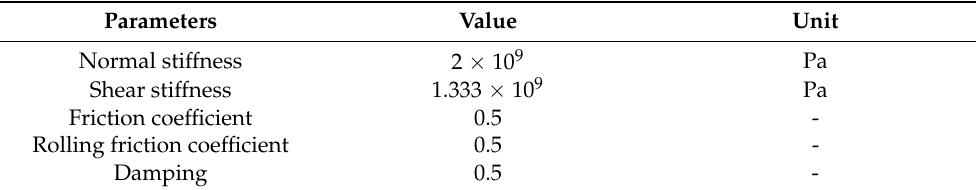
Table 2. Micro parameters for the rolling resistance linear model.